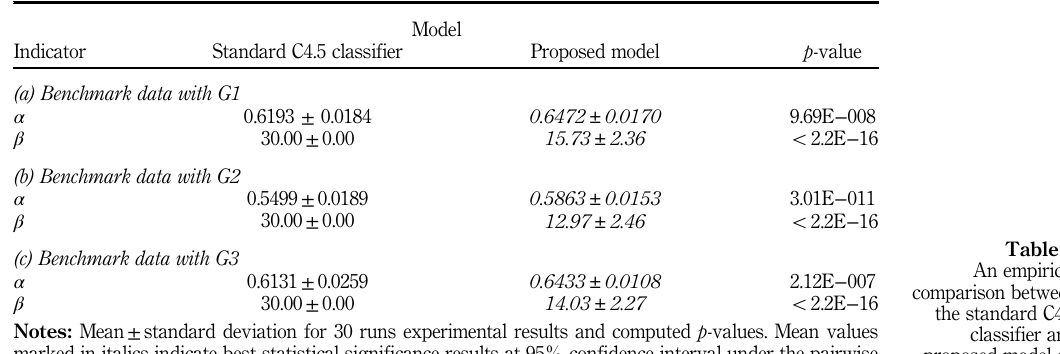
Table I. An empirical comparison between the standard